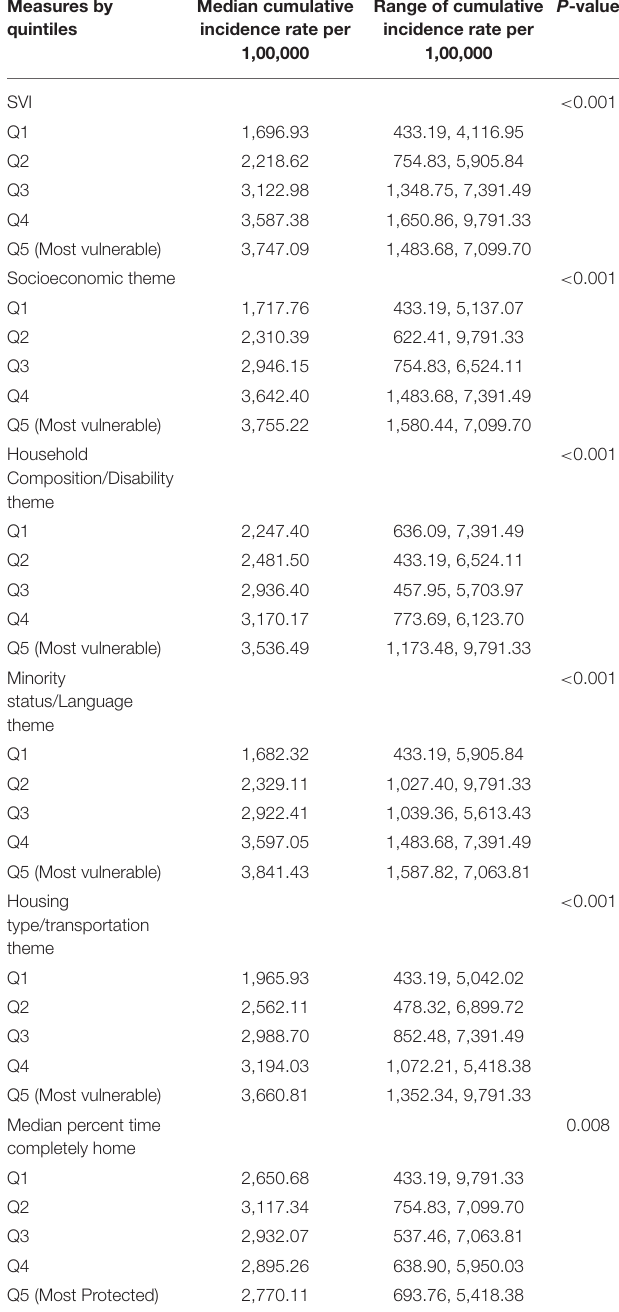
TABLE 2 | Descriptive characteristics of SVI themes and stay-at-home measure by incidence rate per 1,00,000, Harris County, Texas, May 15 to October, 2020. Measures by